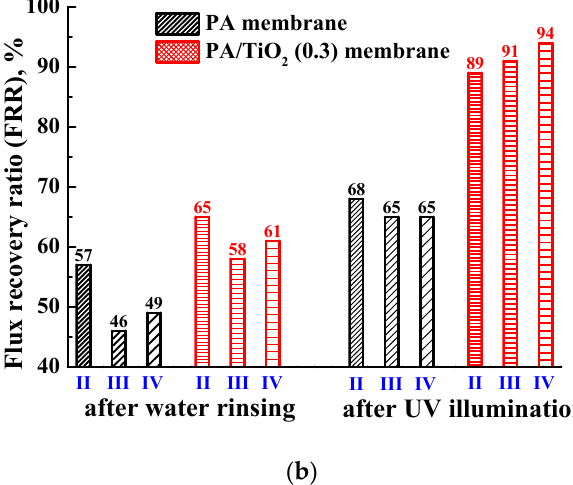
Figure 8. Performance and antifouling stability of the reference PA and modified PA/TiO 2 (0.3) membranes in ultrafiltration of BSA solution: ( a ) the dependence of flux on the time of ultrafiltration; ( b ) flux recovery ratio (FRR) after water rinsing and after ultraviolet illumination for 2.5 h during four cycles. Rejection coefficient of BSA for all membranes was ~60 ± 5%.